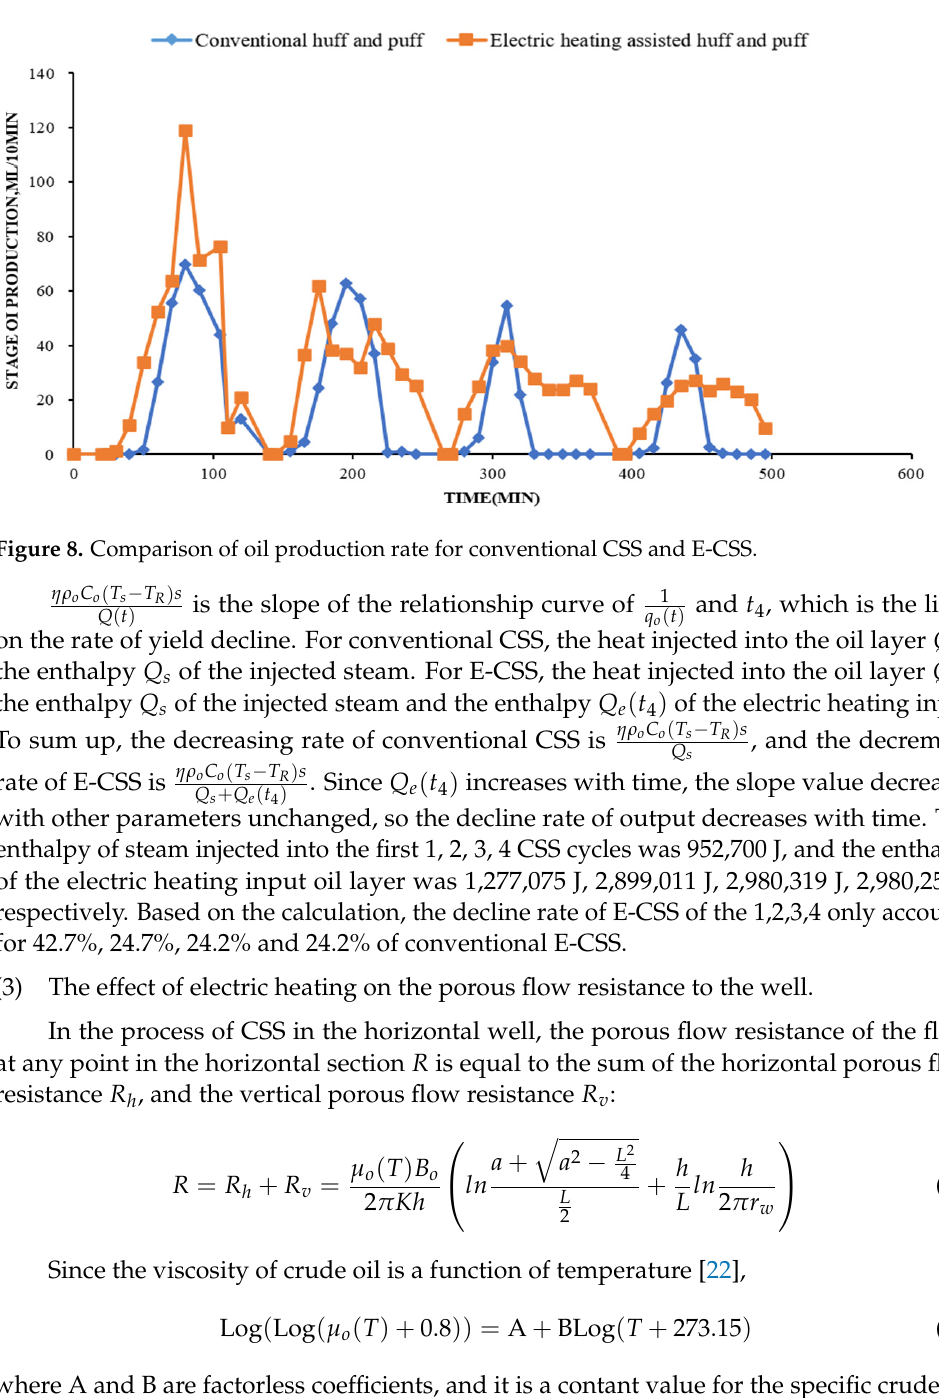
Replace Formula (16) into (14) to obtain the flow resistance R of conventional CSS and the flow resistance R e of